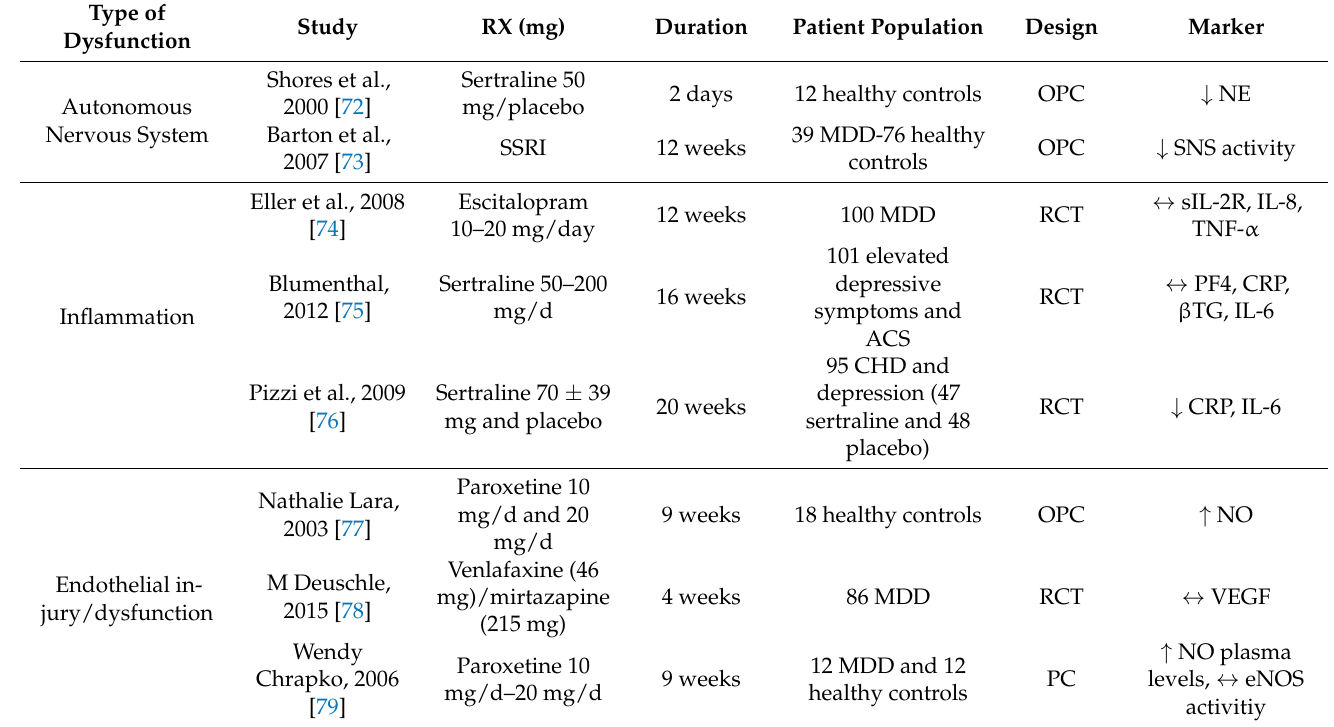
Table 2. The effect of antidepressants on human molecular